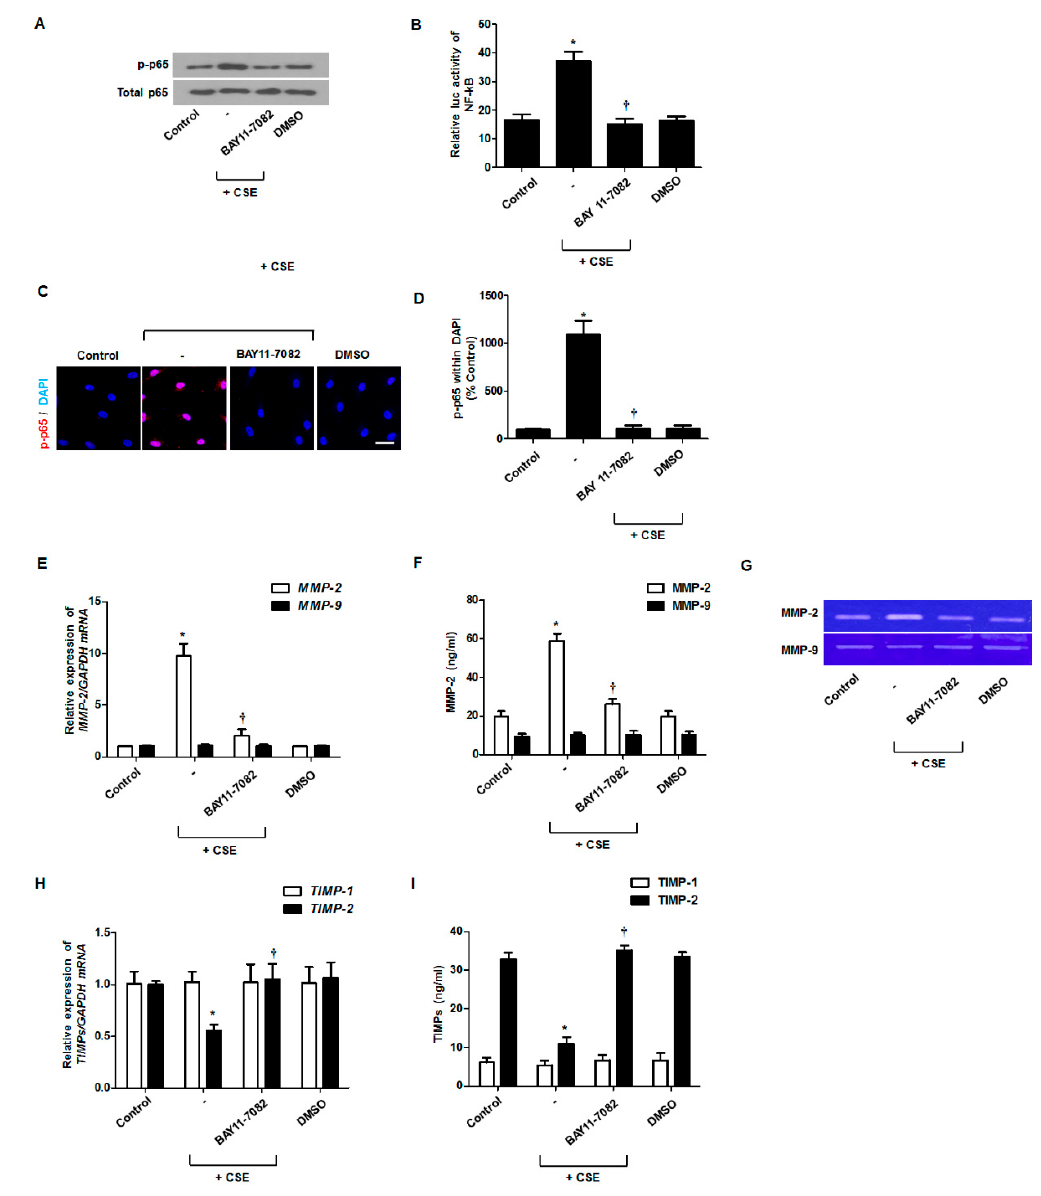
Figure 4. Effects of NF- κ B activation on CSE-regulated MMP and TIMP levels in nasal fibroblasts. Nasal fibroblasts were pretreated with an NF- κ B inhibitor (BAY 11-7082) before treatment with 5% CSE. Phospho (p)-p65 was measured using western blotting to determine NF- κ B activation ( A ). NF- κ B transcriptional activation was measured using the luciferase assay ( B ). After stimulation with CSE, the translocation of p-p65 protein (red) was observed by immunofluorescent staining. Magnification, × 400 ( C , D ). Nuclei were stained using DAPI (blue). The expression levels of MMP and TIMP mRNAs were determined by real-time PCR ( E , F ). The secretion levels of MMP and TIMP proteins were determined using ELISA ( H , I ). The enzymatic activities of MMP-2 and MMP-9 were measured by gelatin zymography ( G ). * p < 0.05 vs. control; † p < 0.05 vs. CSE only. Each experiment was performed three biological replicates. Scale bar = 100 μ m.